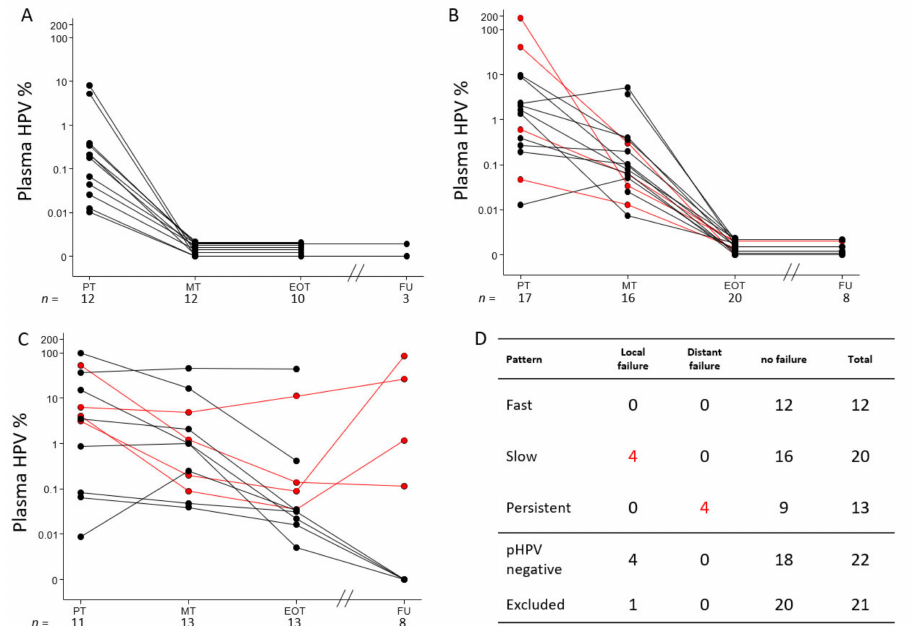
Figure 3. Elimination patterns of pHPV. Patients with measurable pHPV during treatment were divided into three groups. ( A ) 12 patients with a fast pHPV elimination pattern. ( B ) 20 patients with slow pHPV elimination pattern. ( C ) 13 patients with molecular persistent disease. In ( D ), the relation between the pattern and treatment outcome are outlined, including 22 patients with undetectable pHPV and the 21 patients who were excluded due to insufficient repeated pHPV measurements. Highly significant differences were detected between all patterns, Fishers exact p < 0.01. Red lines represent patients with treatment failure. X -axis show sample collection time: Prior to treatment (PT), Mid treatment (MT), End of treatment (EOT) and at one to three years follow up (FU). Y -axis measure the level of plasma HPV in percent of total DNA level. Horizontal lines with a pHPV value of zero are separated to illustrate the progression of each case, and sample size ( n ) is measured below each time